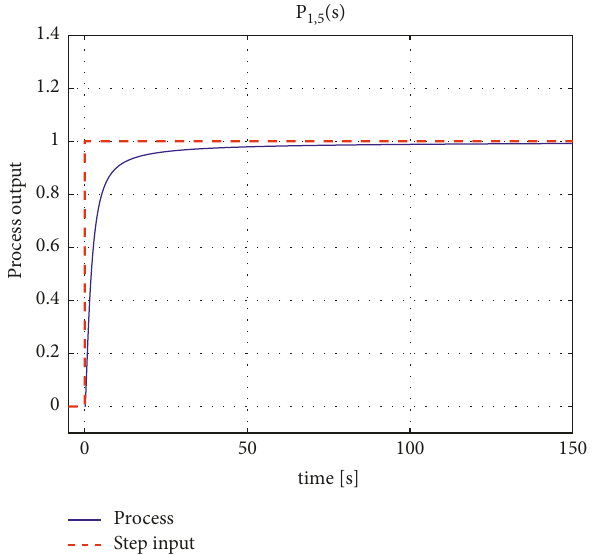
Figure 10: Step-input signal and process reaction curve for process P